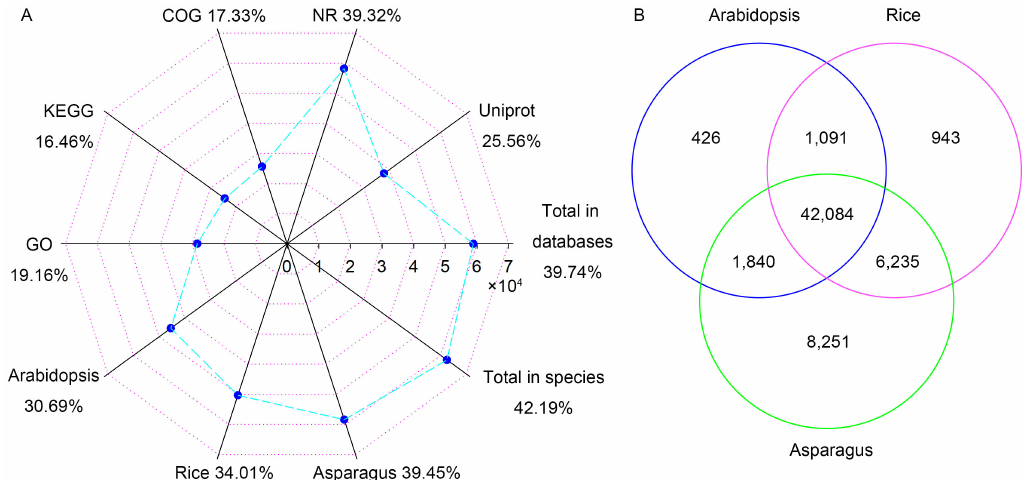
Figure 1. Numbers and rates of unigenes that were annotated in 5 public databases and 3 plant species ( A ). Numbers of unigenes that matched homologs in Arabidopsis , rice and Asparagus ( B ).